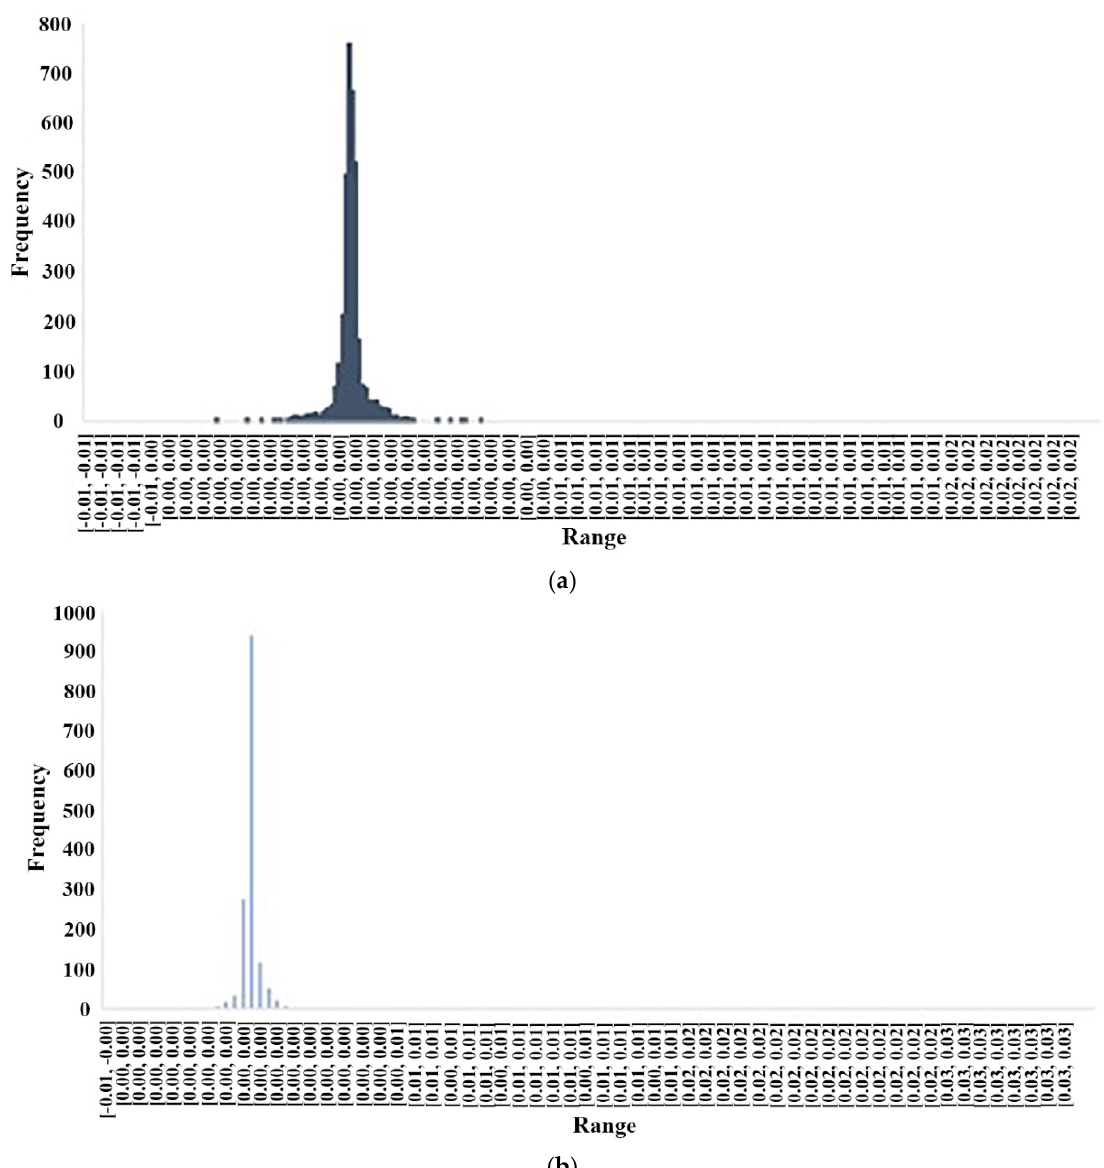
Figure 15. ANFIS error histograms for the best model: ( a ) train phase and ( b ) test phase. Figure 16 indicates a tolerance diagram of predicted and measured values for both testing and training phases, which contains a comparison of outputs and targets for the selected ANFIS model. Figure 16b certifies the reliable prediction of model 5 and the noticeable accuracy of the ANFIS.